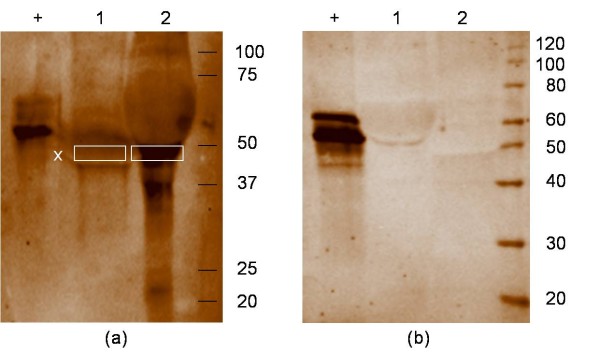
Detection of citrullinated proteins in IC of RA SF (a) and RA serum (b) after immunoprecipitation. 1D-PAGE and AMC staining were performed on the isolated IC and the flow through after IP, from synovial fluid and serum of RA patients. Where (+) is the positive control for AMC staining; the flow-through is shown in lane 1 and the IC-fraction in lane 2. Citrullinated proteins could be detected in the IC isolated by IP in the SF of RA patients (a) and were absent in the sera of RA patients (b). In the fraction indicated by "x";, immunoglobulins, serum albumin and Fibβ were identified by mass spectrometry.